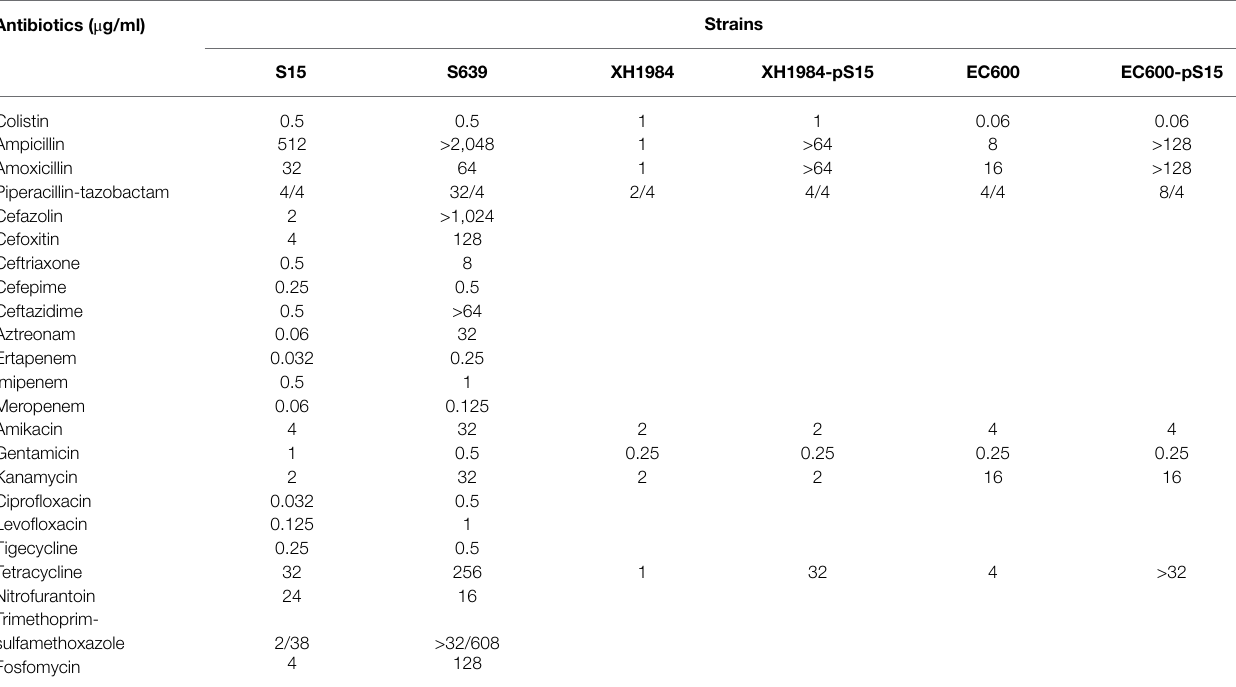
TABLE 2 | Summary of antimicrobial susceptibility testing. Antibiotics ( μ